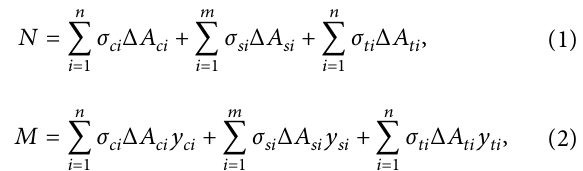
Figure 6: Distribution of deflection along length.